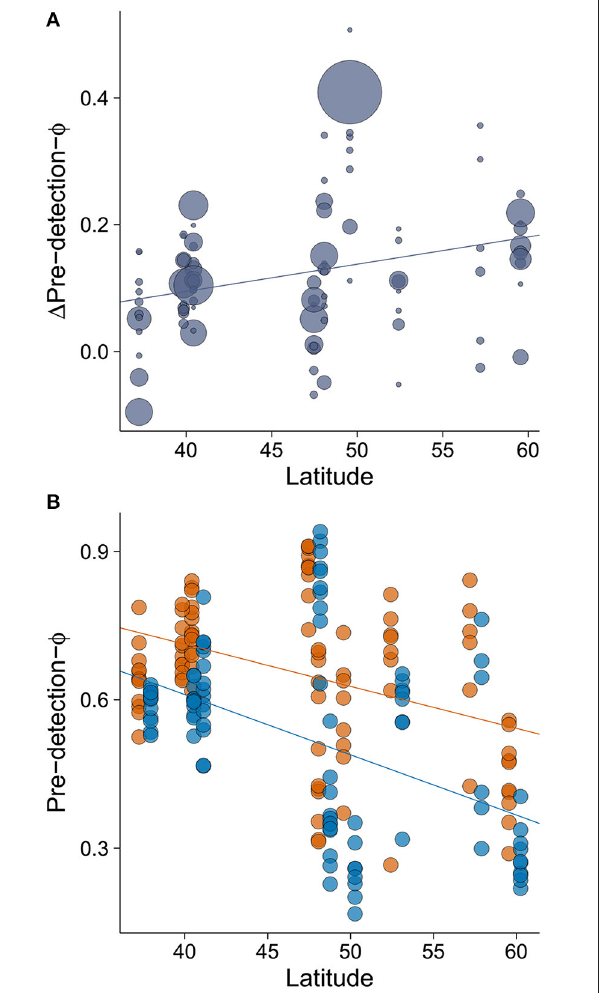
FIGURE 4 | The relationship between (A) latitude and rural-urban difference in pre-detection- 8 ( 1 pre-detection- 8 ) and (B) the relationship between latitude and pre-detection- 8 by site. Lower values of pre-detection- 8 mean that birds took longer to be alerted to an approaching human. The size of the circles in plot A is proportional to sample size for a given population (min = 19, max = 358). In plot (B) , orange points and orange line represent rural populations whereas blue points and blue line represent urban populations. Circle size was fixed but points representing urban birds have been slightly displaced to the right (0.7 ◦ of latitude) to improve data visualization. Lines illustrate linear